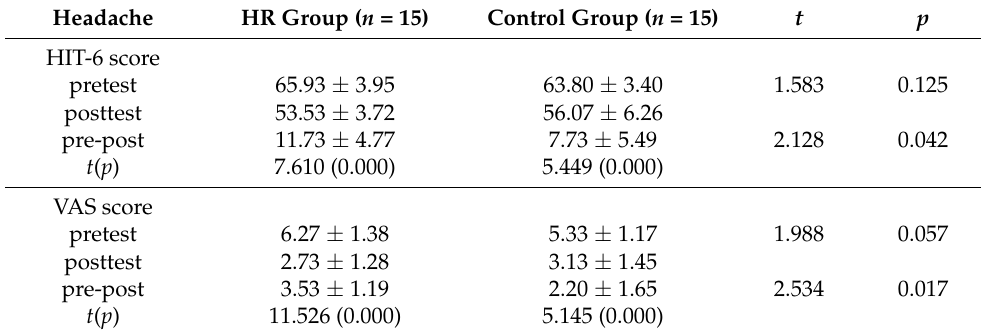
Table 2. Comparison of headache intensity (N = 30).